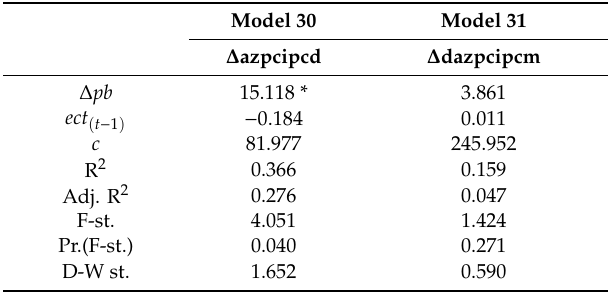
Table 5. The influence of oil price on macroeconomic indicators (Azerbaijan).